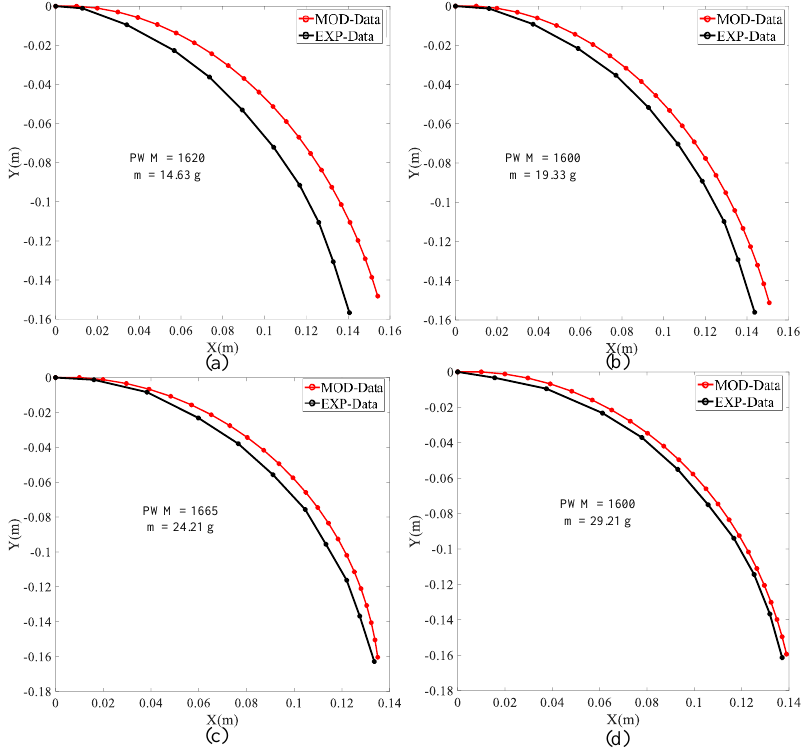
Figure 8. ( a – d ) shown the comparison of experimental and model analysis results for different mass loads suspended from the end of the soft arm.